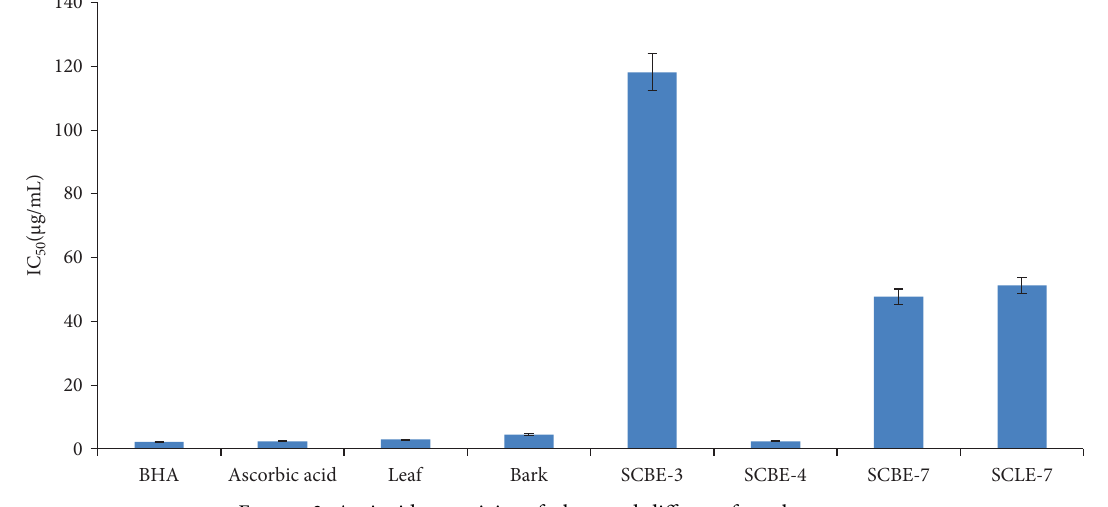
Figure 3: Antioxidant activity of plant and diferent fungal